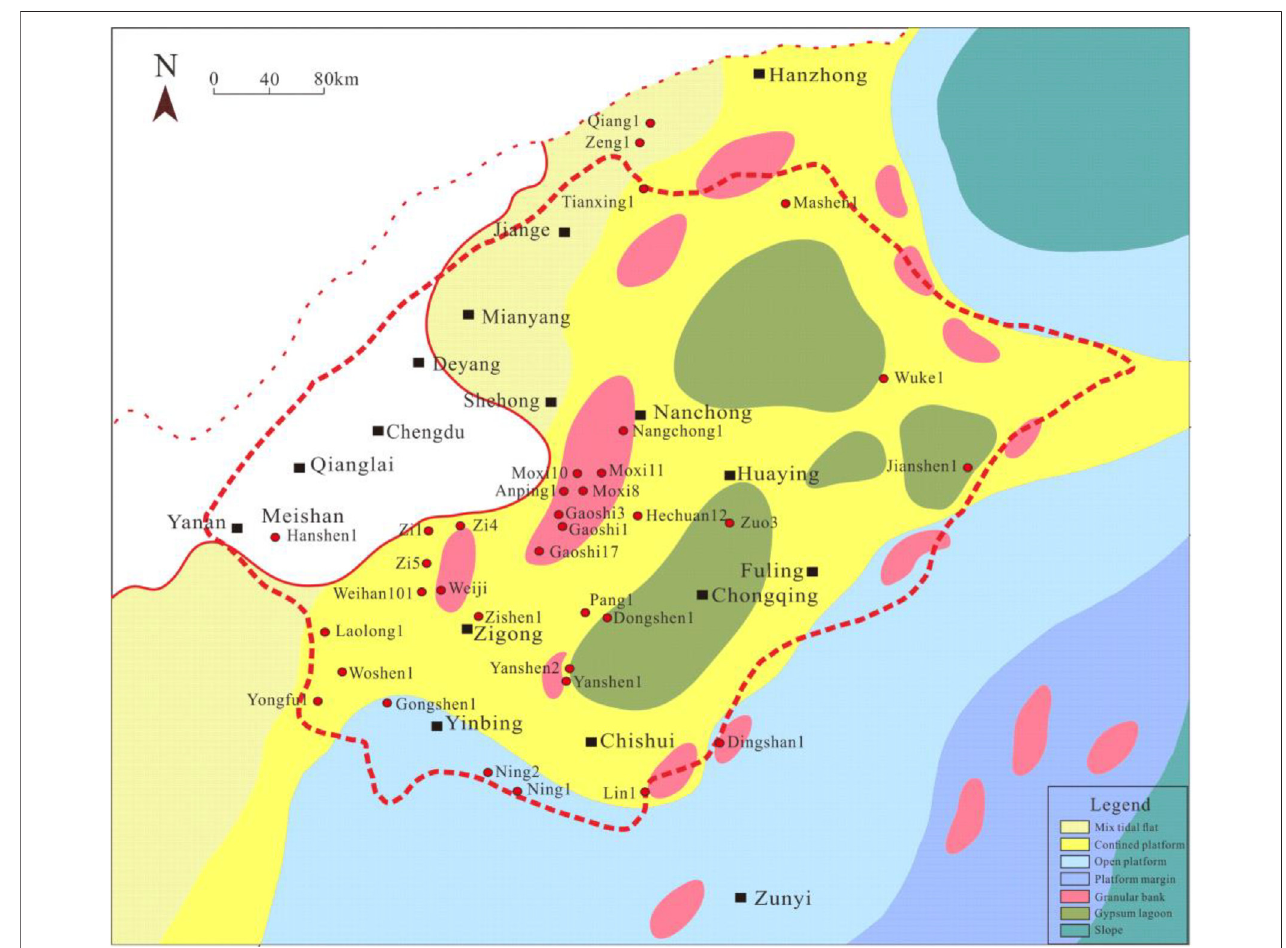
FIGURE 1 | Plane distribution of sedimentary facies of the Lower Cambrian Longwangmiao Formation in the Sichuan Basin.